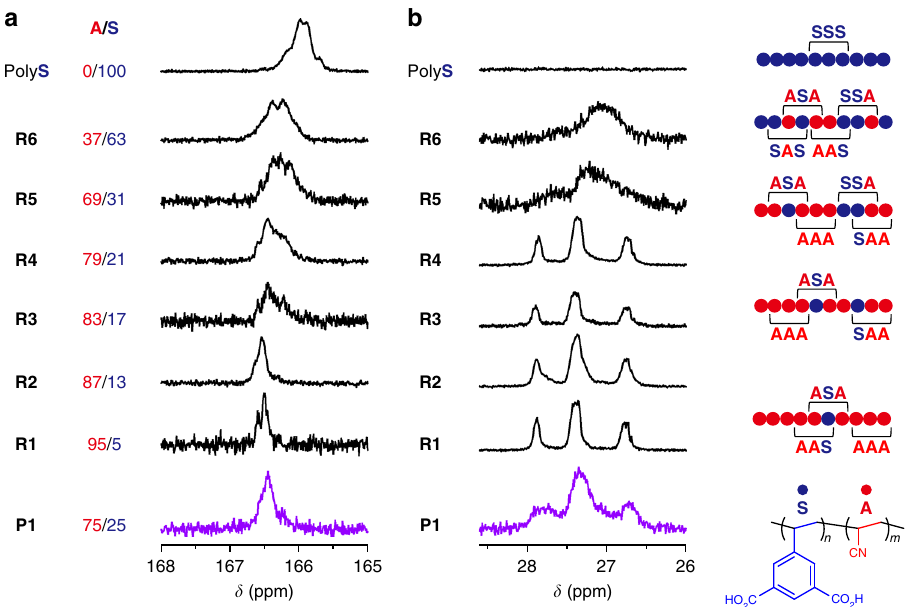
Fig. 5 Structural characterization of polymers using 13 C NMR. 13 C NMR spectra focusing on carbonyl ( a ) and methine carbons ( b ) of polymers, from which S - and A -centred triads can be analyzed, respectively. Plausible monomer sequences of random copolymers ( R1 – 6 ) are shown together with their NMR spectra. The predominant triads of P1 could be estimated to be ASA , AAS and AAA by comparison of the peak shapes and peak positions for P1 , random copolymers ( R1 – 6 ) and poly S